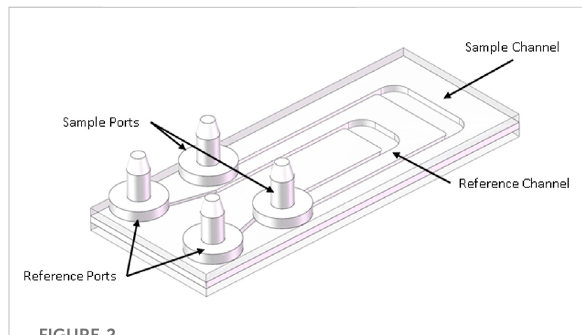
FIGURE 2 Sample aliquot chamber (SAC): The SAC consisted of two channels,alargersamplechannelandasmallerreferencechannel. These channels were connected to the SPU via tubing, itself connected to the SAC via barbed connectors. Image credit Mineh